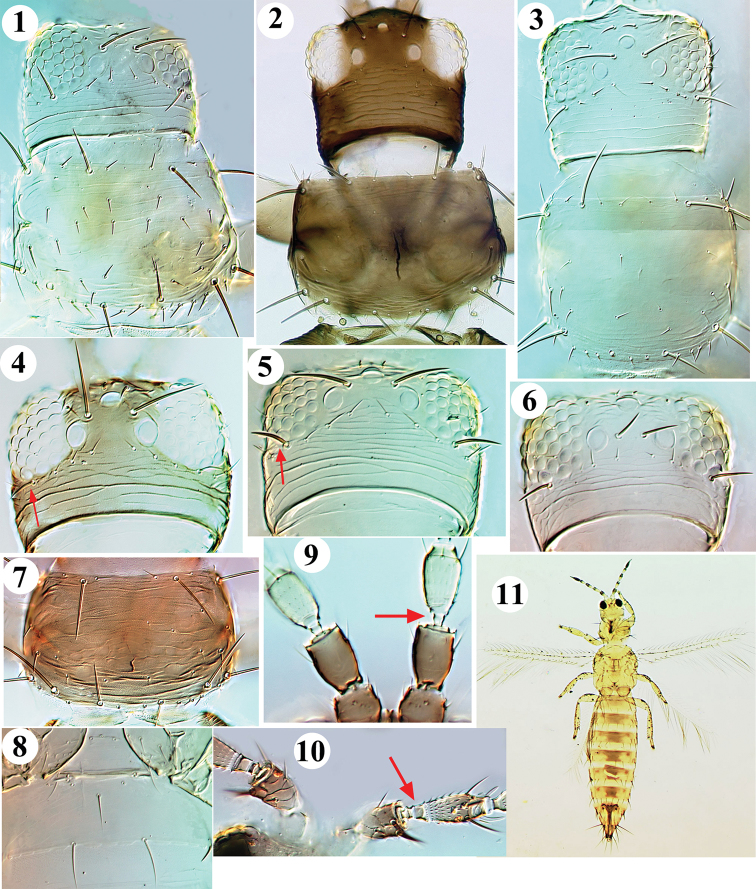
Frankliniella from China. Head & Pronotum: 1cephalica2tenuicornis3williamsi. Head: 4intonsa5occidentalis6schultzei. 7intonsa pronotum. 8williamsi sternite II. Antennal segments II–III: 9intonsa10cephalica11occidentalis female.